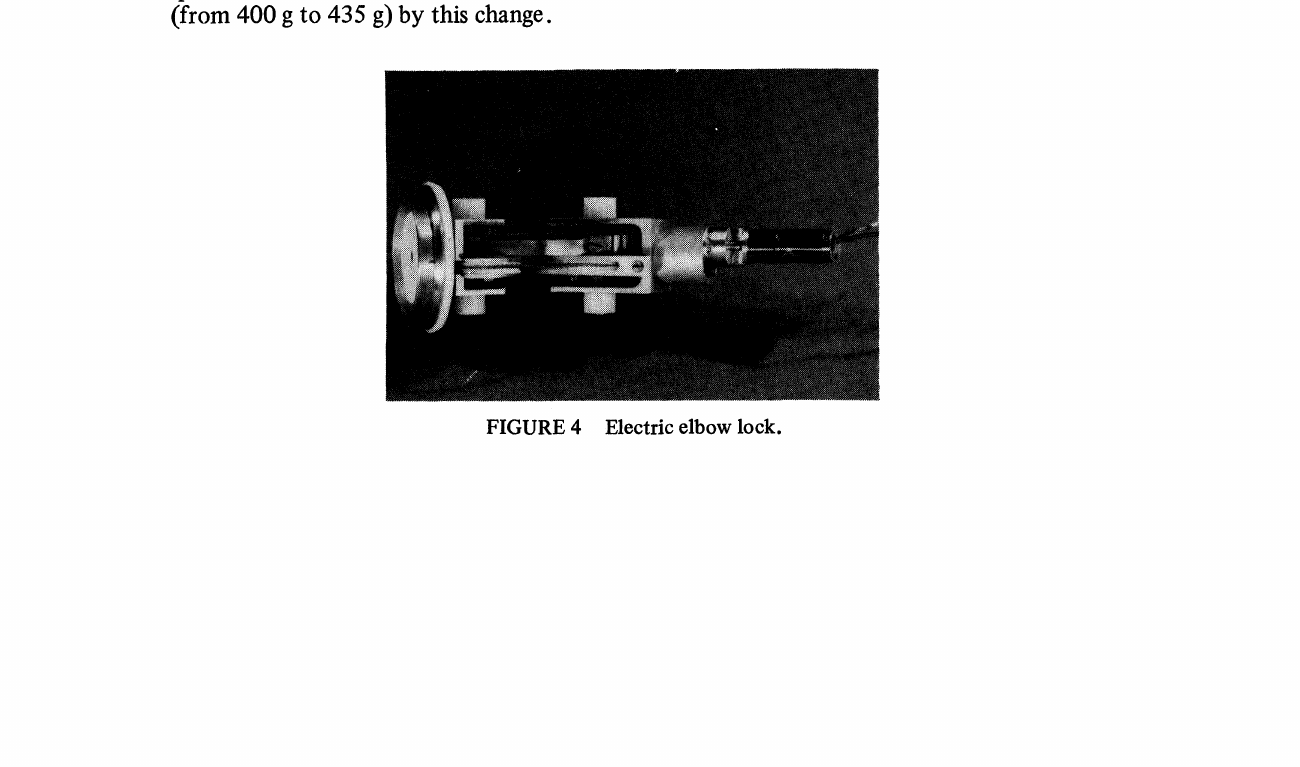
FIGURE 4 Electric elbow